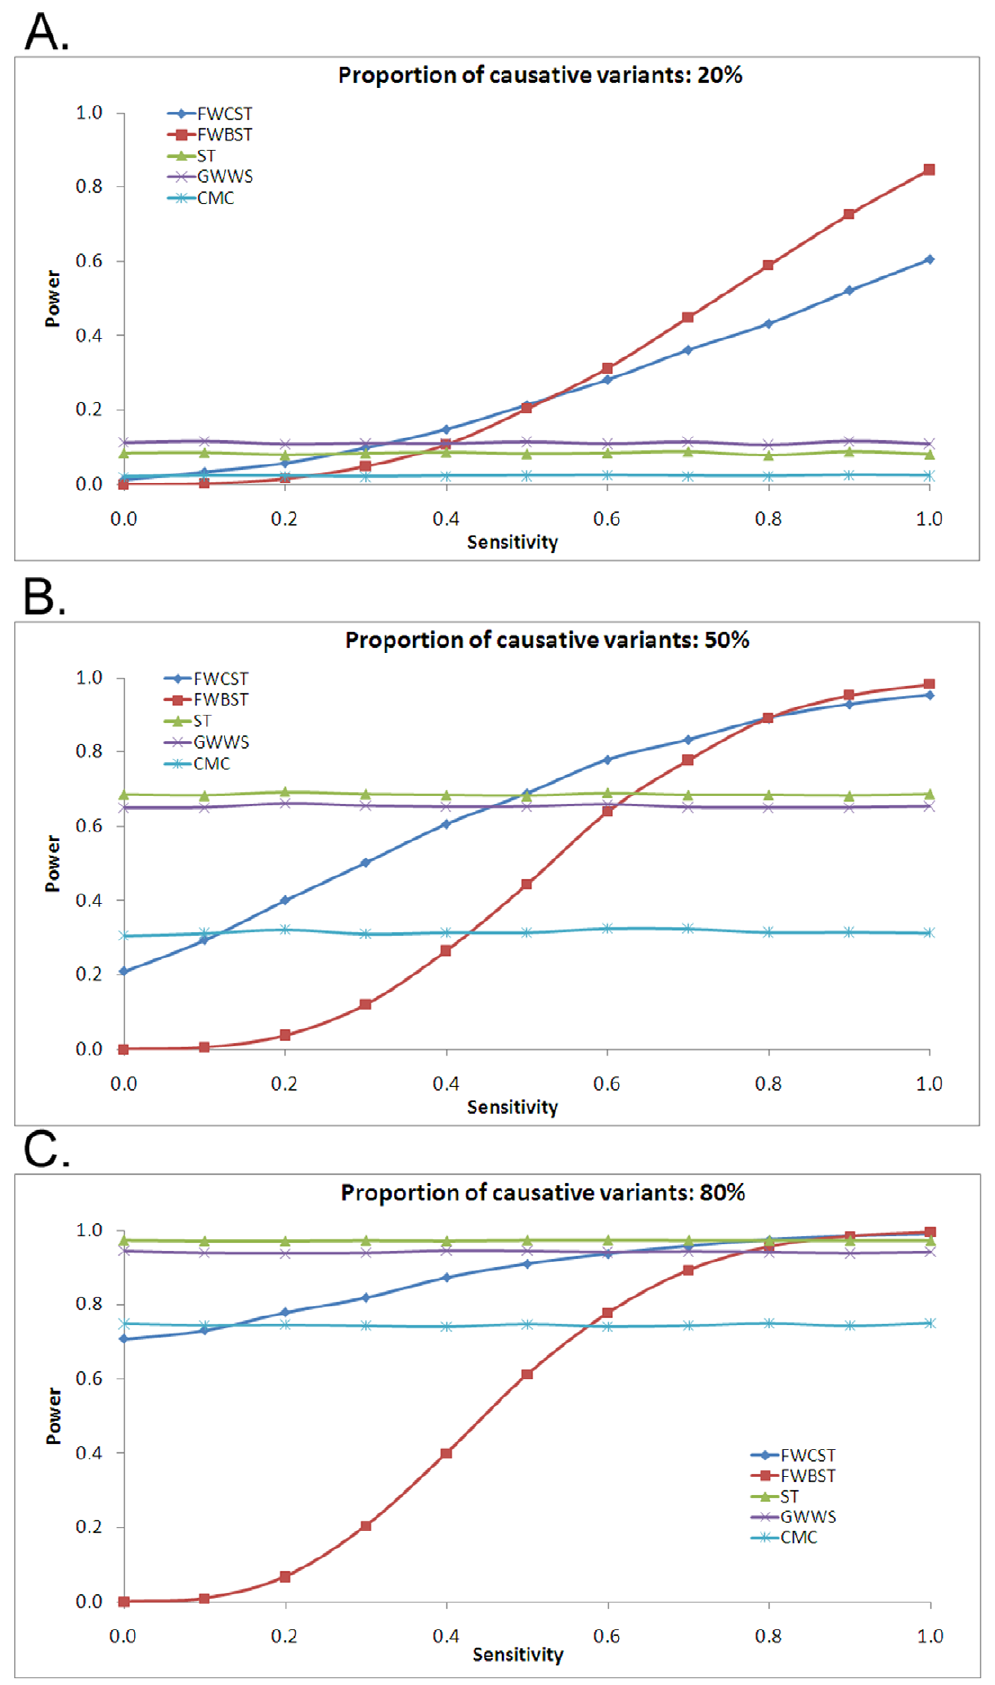
Figure 5. Power with sensitivity of predicting functional variants. Three proportions of causative variants are considered: 20% (A), 50% (B), and 80% (C). The specificity for identifying functional variants is set to 0.15. See the legend for figure 4 for abbreviations and simulation detail. doi:10.1371/journal.pone.0013857.g005 PLoS ONE |